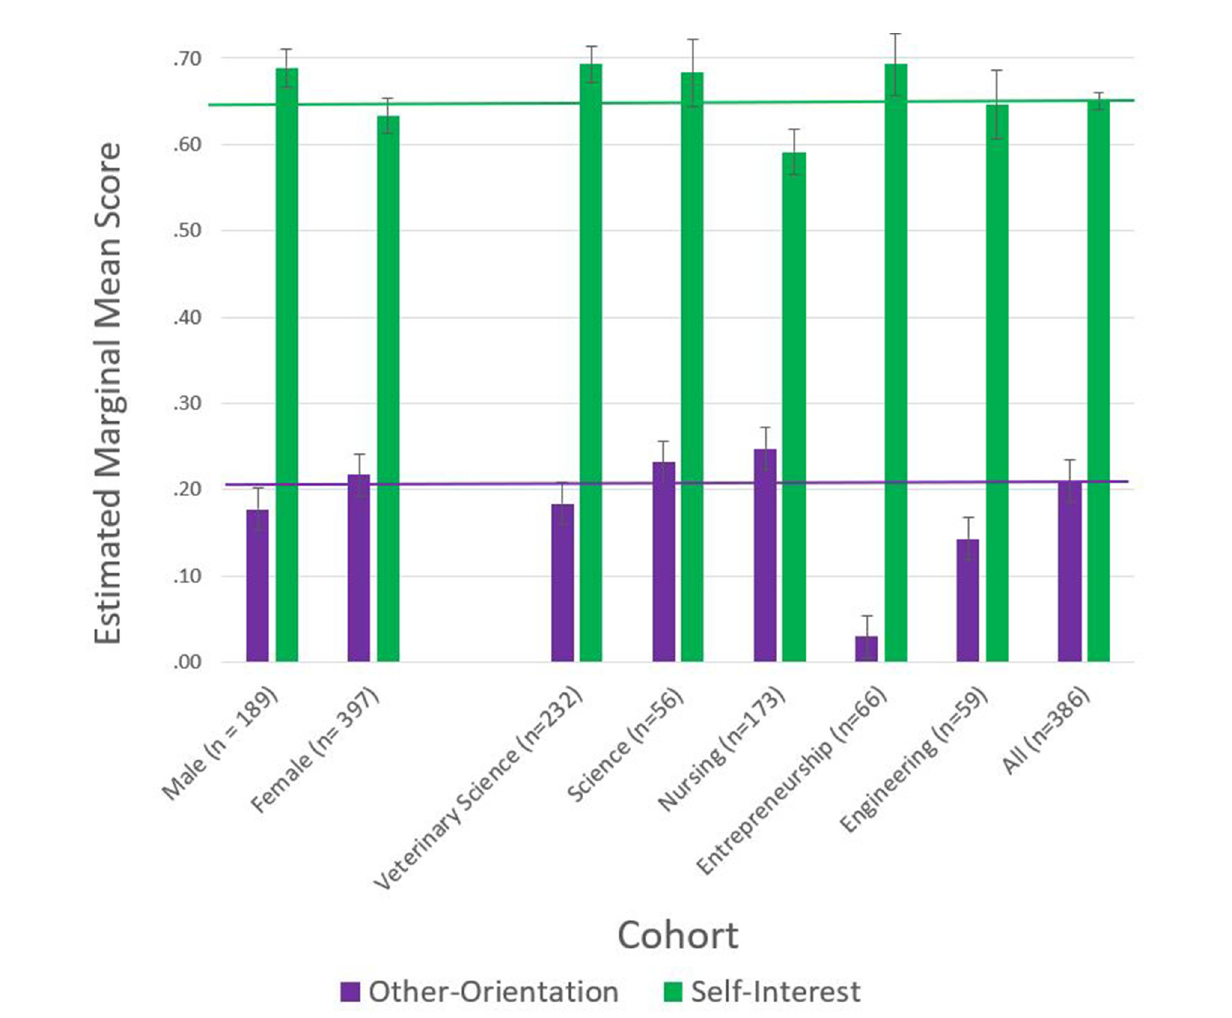
FIGURE2 Estimated marginal means from the MANOVA of other-orientation and self-interest per discipline and gender ( n = 586). Horizontal lines represent study population means for “other-orientation” ( u = 0.21) and “self-interest” ( u = 0.65).